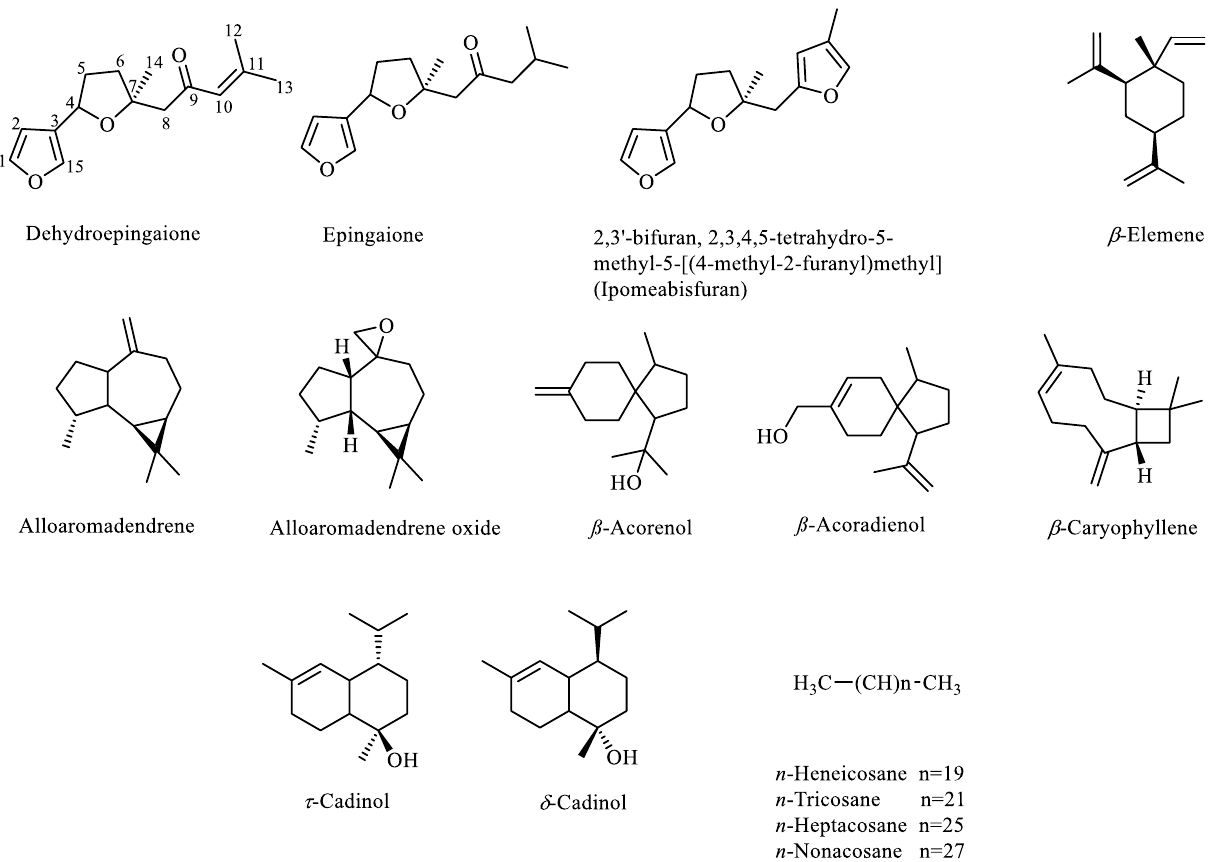
Figure 2. Structures of the major chemical constituents from B. daphnoides essential